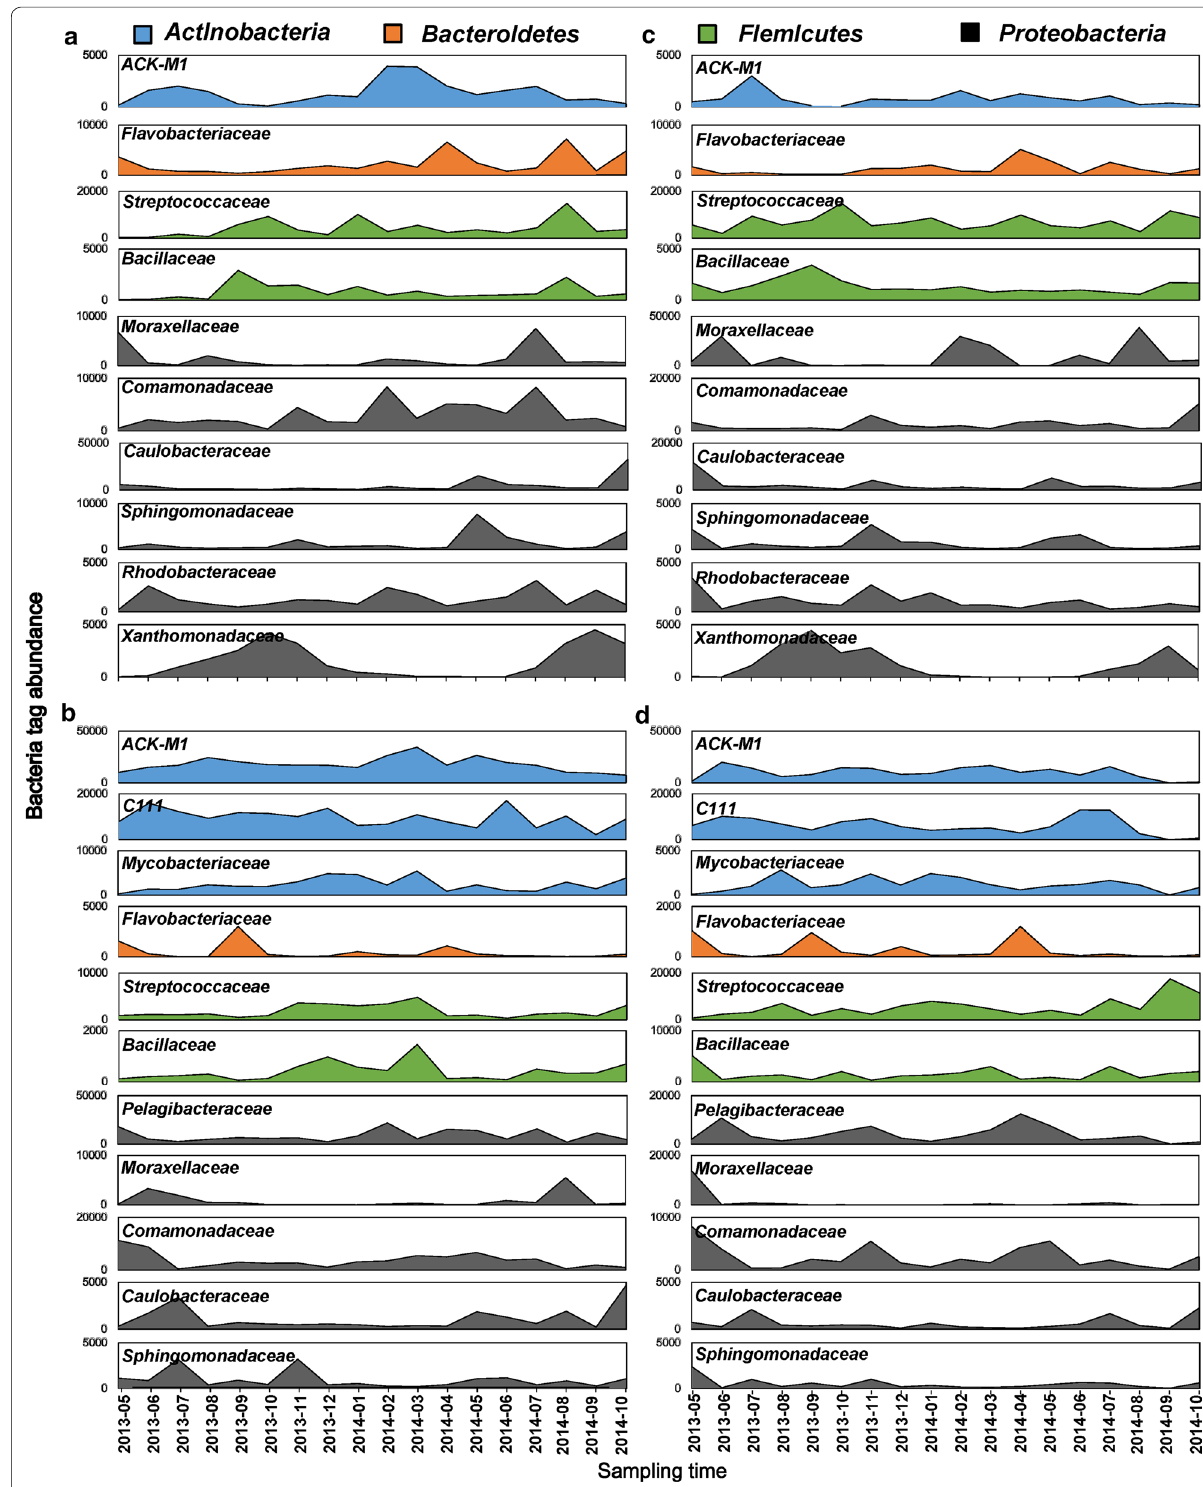
Fig. 3 Seasonal variations in the top 10 dominant bacterial families in Lake Erhai from May 2013 to October 2014 at the two sampling sites ( a , b for site 1; c , d for site 2). a , c Composition of the 10 dominant attached bacterial families; b , d composition of the dominant free-living bacterial families. Color codes represent the same phyla in all pictures, and the Y-axis scales